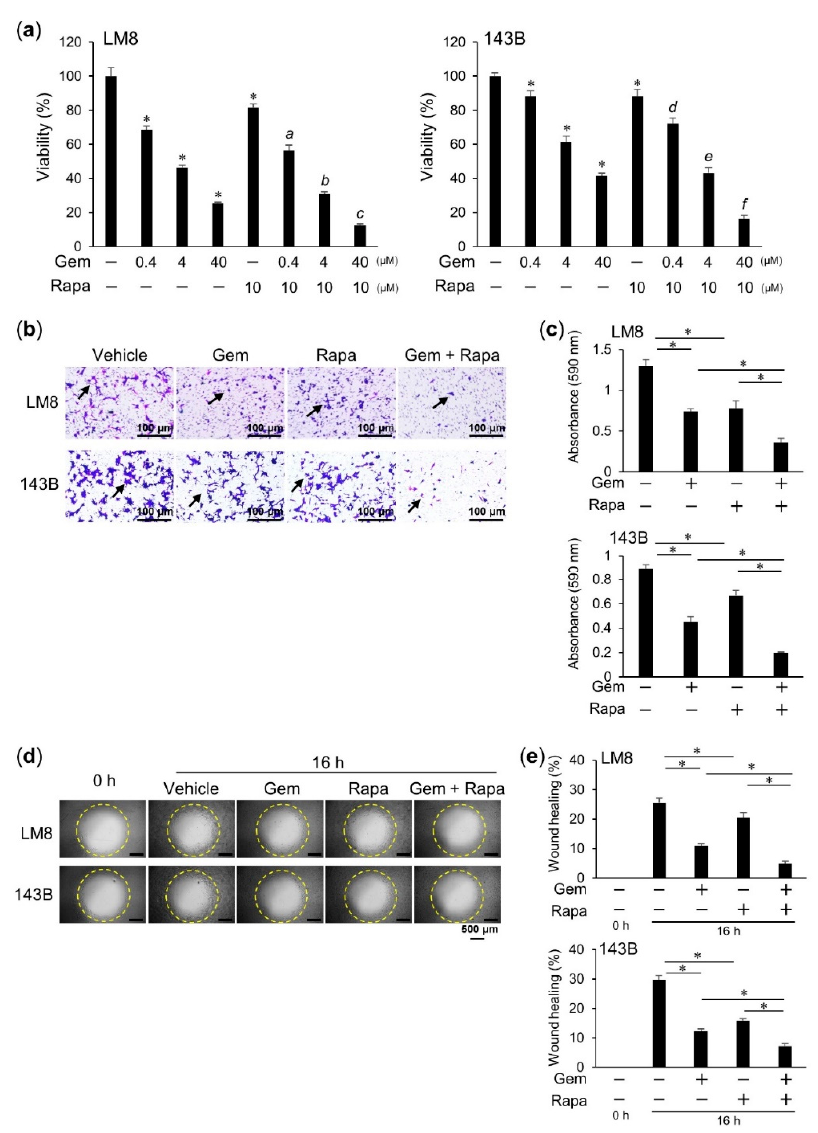
Figure 1. The gemcitabine–rapamycin (Gem–Rapa) combination reduces viability, invasion, and migration of osteosarcoma (OS) cells. ( a ) LM8 and 143B cells were treated with Gem alone or in combination with Rapa and cell viability was measured. Data are shown as the mean ± SD ( n = 4). * p < 0.05 vs. vehicle; a–f, p < 0.05 vs. Rapa alone. ( b ) Invasion assays were performed (arrows indicate invaded cells; scale bar, 100 = μ m). ( c ) The absorbance of invading cells was quantified. Data represent the mean ± SD ( n = 3). * p < 0.05. ( d ) Cell migration was evaluated. LM8 and 143B cells were treated with Gem alone or in combination with Rapa (scale bar, 500 = μ m). ( e ) Pre-migration and post-migration images were analyzed. Data are represented as the mean ± SD ( n = 3). * p < 0.05.